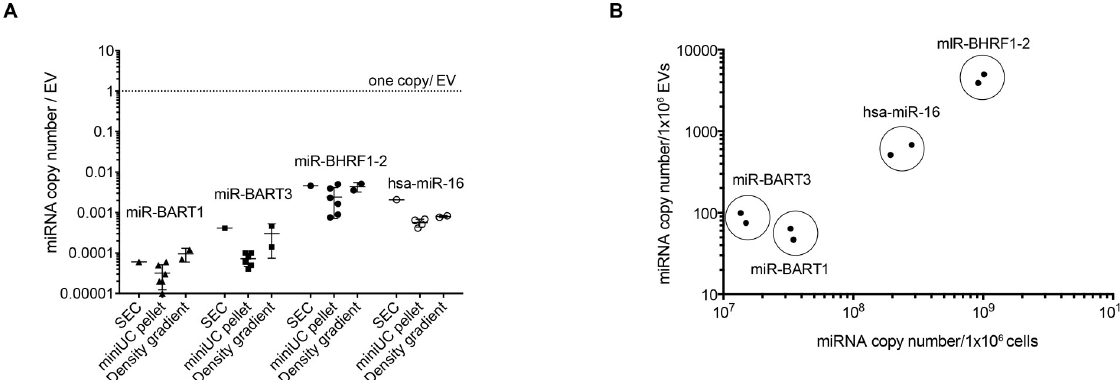
Fig 7. Single miRNAs are very scarce in EVs. Three different preparations of EVs were obtained from conditioned medium of LCLs infected with wild-type EBV. EVs were purified by differential centrifugation (‘miniUC pellet’; Fig 2A), by size exclusion chromatography (SEC, fractions 7–9 were combined and analyzed; Fig 3A), or by iodixanol (Optiprep) density gradient centrifugation (fractions 2 and 3 were combined and analyzed; Fig 1D). Concentrations of EVs were determined by NTA. RNA was isolated from the three preparations (resuspended miniUC pellet, SEC and density gradient fractions), and absolute copy numbers of four different miRNAs were determined using a TaqMan stem loop RT-qPCR. For each miRNA, a standard curve of a synthetic RNA oligonucleotide (mimicking the miRNA) was established to determine absolute miRNA copy numbers in the preparations. (A) The graph shows the miRNA copy number per EV of three viral miRNAs and the human miRNA hsa-miR-16. (B) The graph indicates the miRNA copy numbers contained in 10 6 EVs (y-axis) as measured by RT-qPCR and NTA, respectively, versus the miRNA copy number contained in 10 6 cells